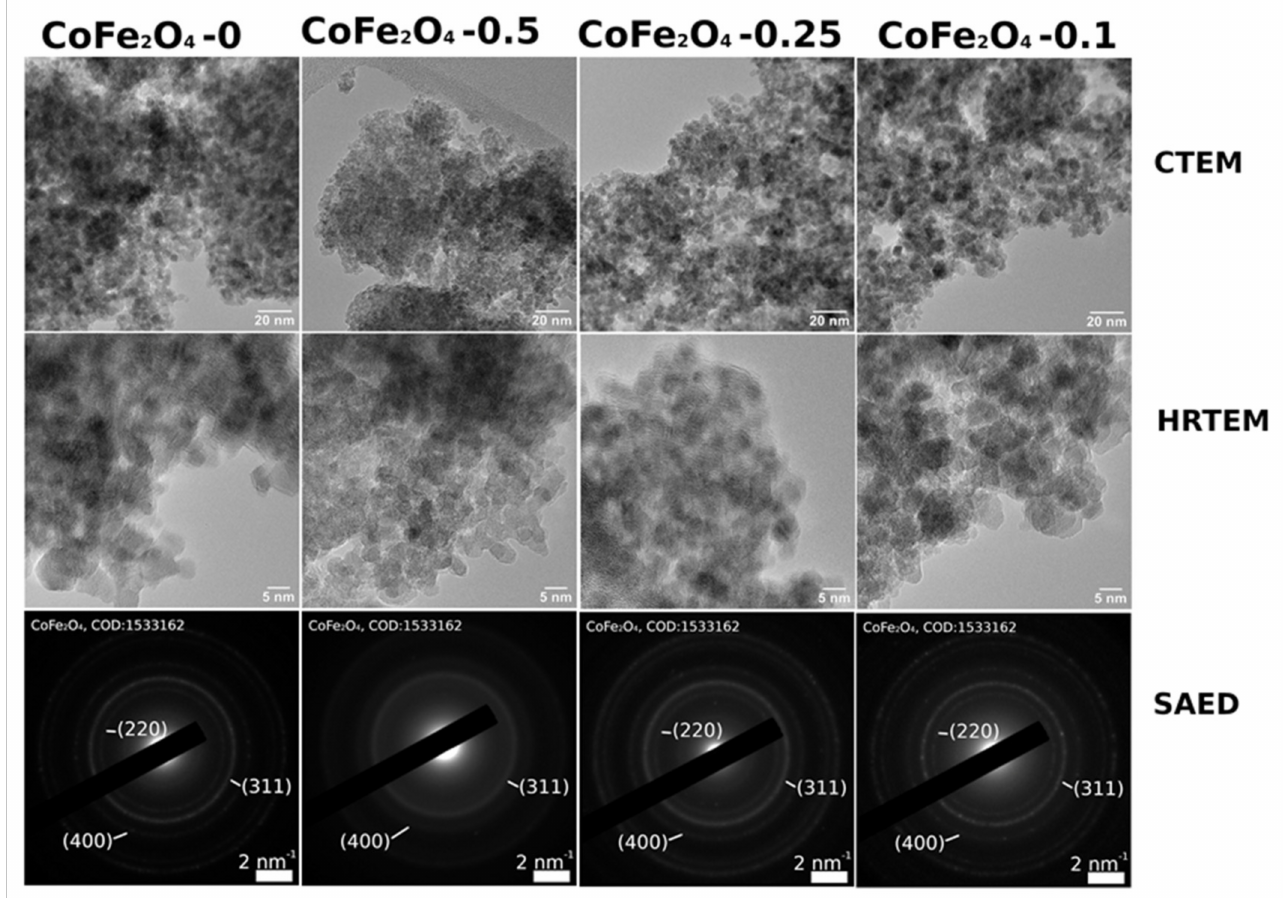
Figure 9. A comparative approach of CTEM images, HRTEM images and SAED profiles as obtained on CoFe 2 O 4